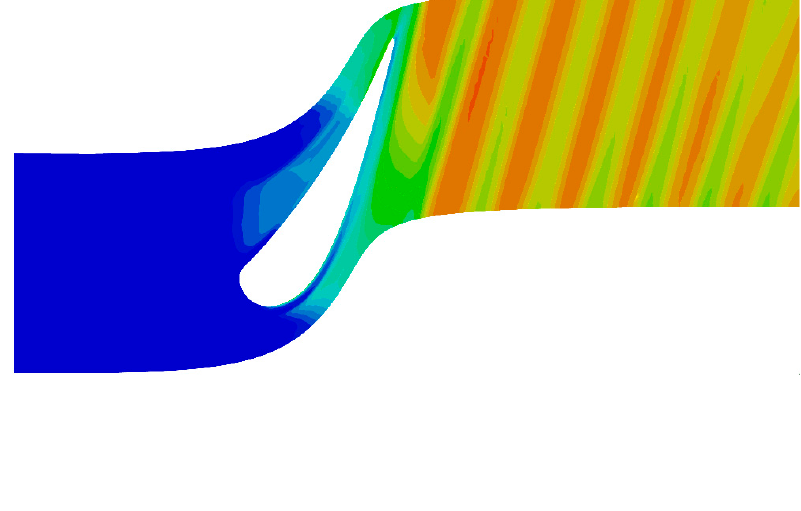
14 of 21 Figure 11. NO mass fractions for conditions C (cruise, H 2 ) and D (cruise, CH 4 ) calculated utilising the CFD model with different chemical reaction mechanisms and chemistry modelling. The aforementioned increase seems to be related to the predicted flow field to a great extent. The NO concentration rises along the passage walls and in the wake of the blades, as shown in Figure 12. This could be a result of the increase in residence time in these